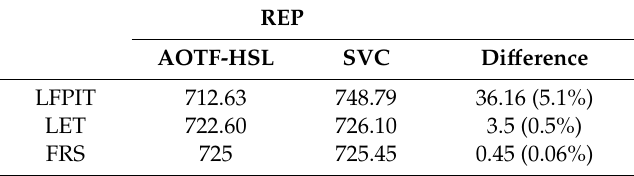
Table 9. The three di ff erent methods’ “Red edge” position results for rubber plant.